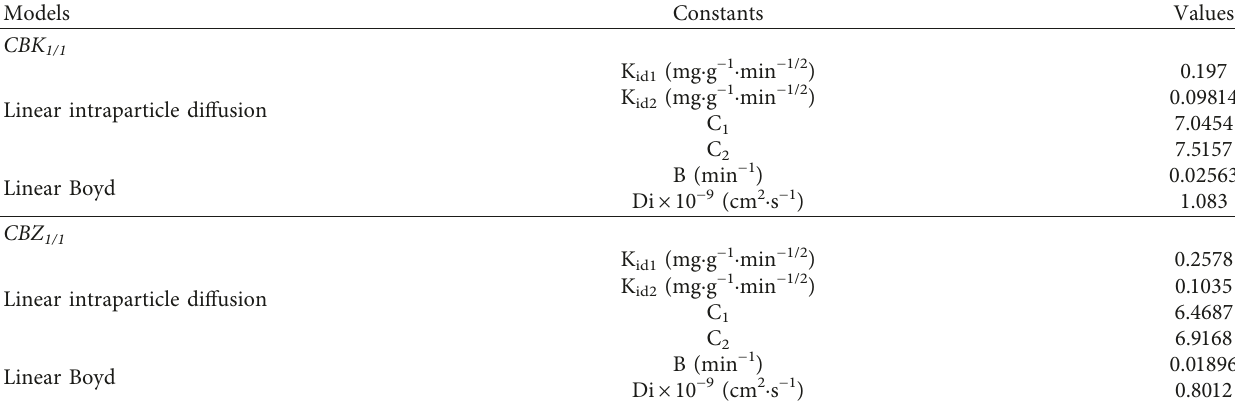
Table 4: Intraparticle diffusion and Boyd parameters for adsorption of IC onto ACs.